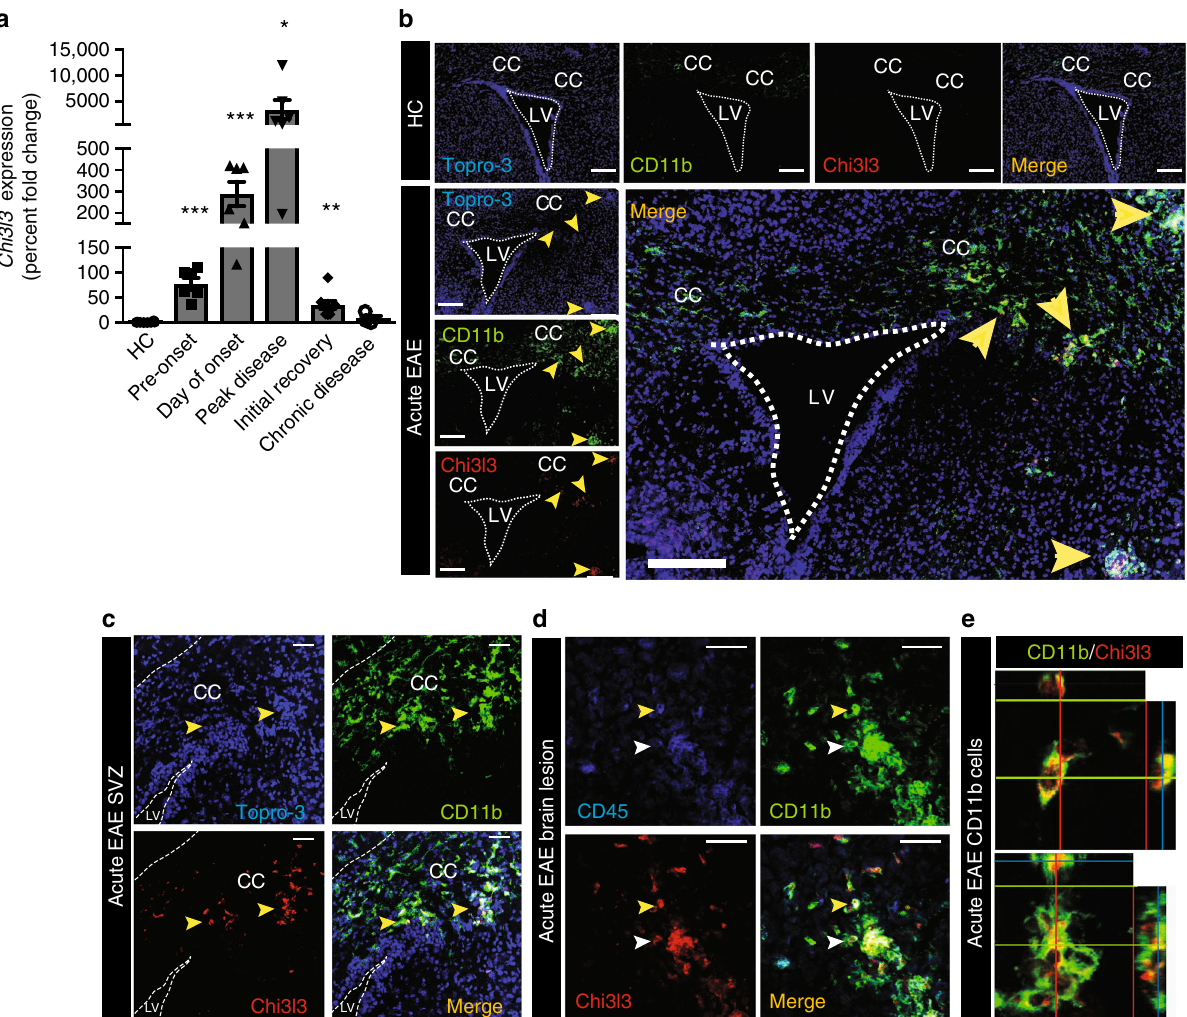
Fig. 1 Endogenous Chi3l3 expression in the adult SVZ during EAE. a Chi3l3 gene expression in the subventricular zone (SVZ) of healthy control mice (HC; n = 8), preclinical EAE (6 days post immunization (dpi; n = 6), EAE onset (13dpi; n = 6), acute EAE (14 dpi; n = 6), initial recovery (18 dpi; n = 8) and chronic EAE (36 dpi, n = 6) measured by qRT-PCR (multiple t -tests with Dunn – Bonferroni ’ s multiple comparison test). b – e Confocal images of the SVZ of representative healthy controls (HC), acute EAE mice (12 – 14 dpi). Sections were immunostained for the nuclear marker TO-PRO-3 (blue), Chi3l3 (red) and the microglia/macrophage marker CD11b (green, b – e ) and the lymphocyte common antigen CD45 (blue, d ). Chi3l3 expression in the SVZ was only detected during acute EAE and was localized to CD11b-positive cells (yellow arrowheads) within the corpus callosum (CC) c and lesions d , where they co- expressed CD45 at high (yellow arrowhead) and low levels (white arrowhead). Dashed lines mark the wall of the lateral ventricle (LV). Scale bar, 200 μ m. e Ortho-view images of representative Chi3l3 + /CD11b + double-positive cells exhibiting round (upper panel) and rami fi ed (lower panel) morphology. (mean ± s.e.m. * p < 0.05; ** p < 0.01; *** p <